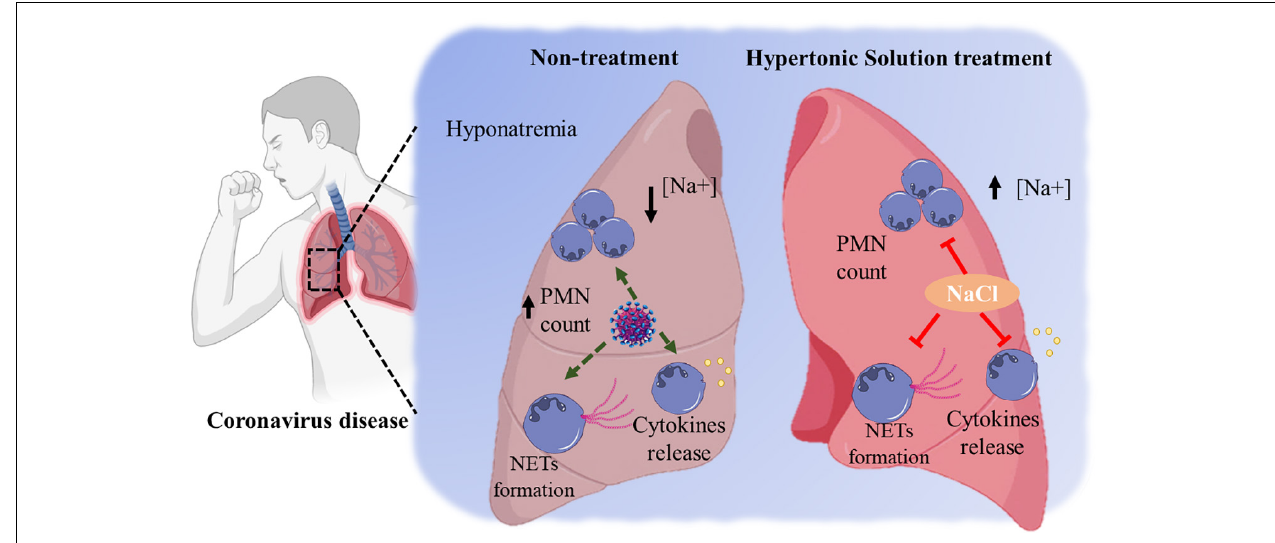
FIGURE 1 | The possible beneficial effects of hypertonic saline solution decreasing neutrophils’ hyperresponsiveness in the coronavirus